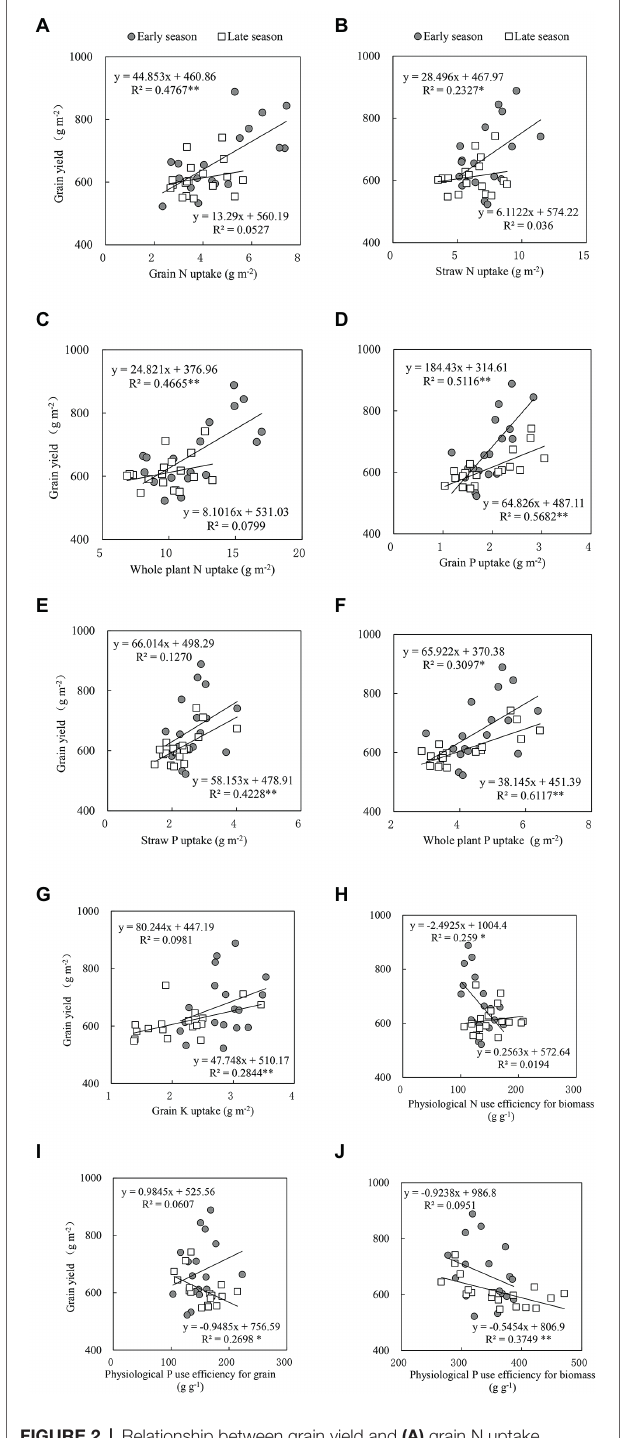
FIGURE 2 | Relationship between grain yield and (A) grain N uptake, (B) straw N uptake, (C) whole plant N uptake, (D) grain P uptake, (E) straw P uptake, (F) whole plant P uptake, (G) grain K uptake, (H) physiological N use efficiency for biomass, (I) physiological P use efficiency for grain, and (J) physiological P use efficiency for the biomass of both the early and late season double rice cropping systems in South China. **Significant at p < 0.05; *Significant at p < 0.01. A smaller R 2 value means greater